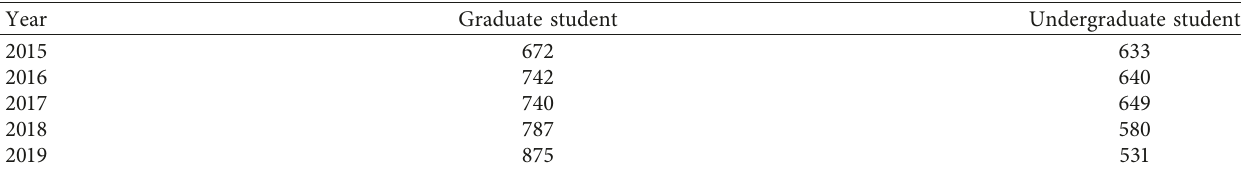
Table 6: The employment data from Nanjing University of Aeronautics and Astronautics in the aerospace and other defense-related industry.